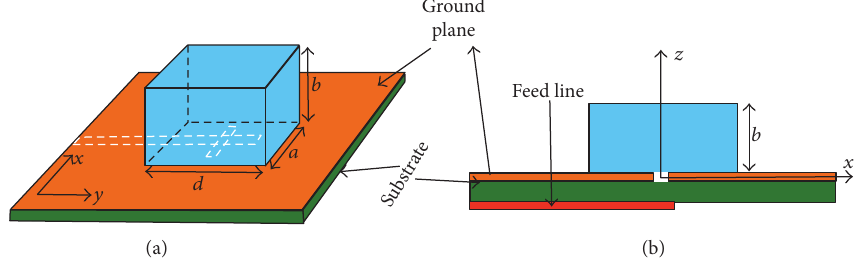
Figure 5: Three-dimensional view (a) and cross-sectional view (b) of an aperture-fed rectangular DRA.